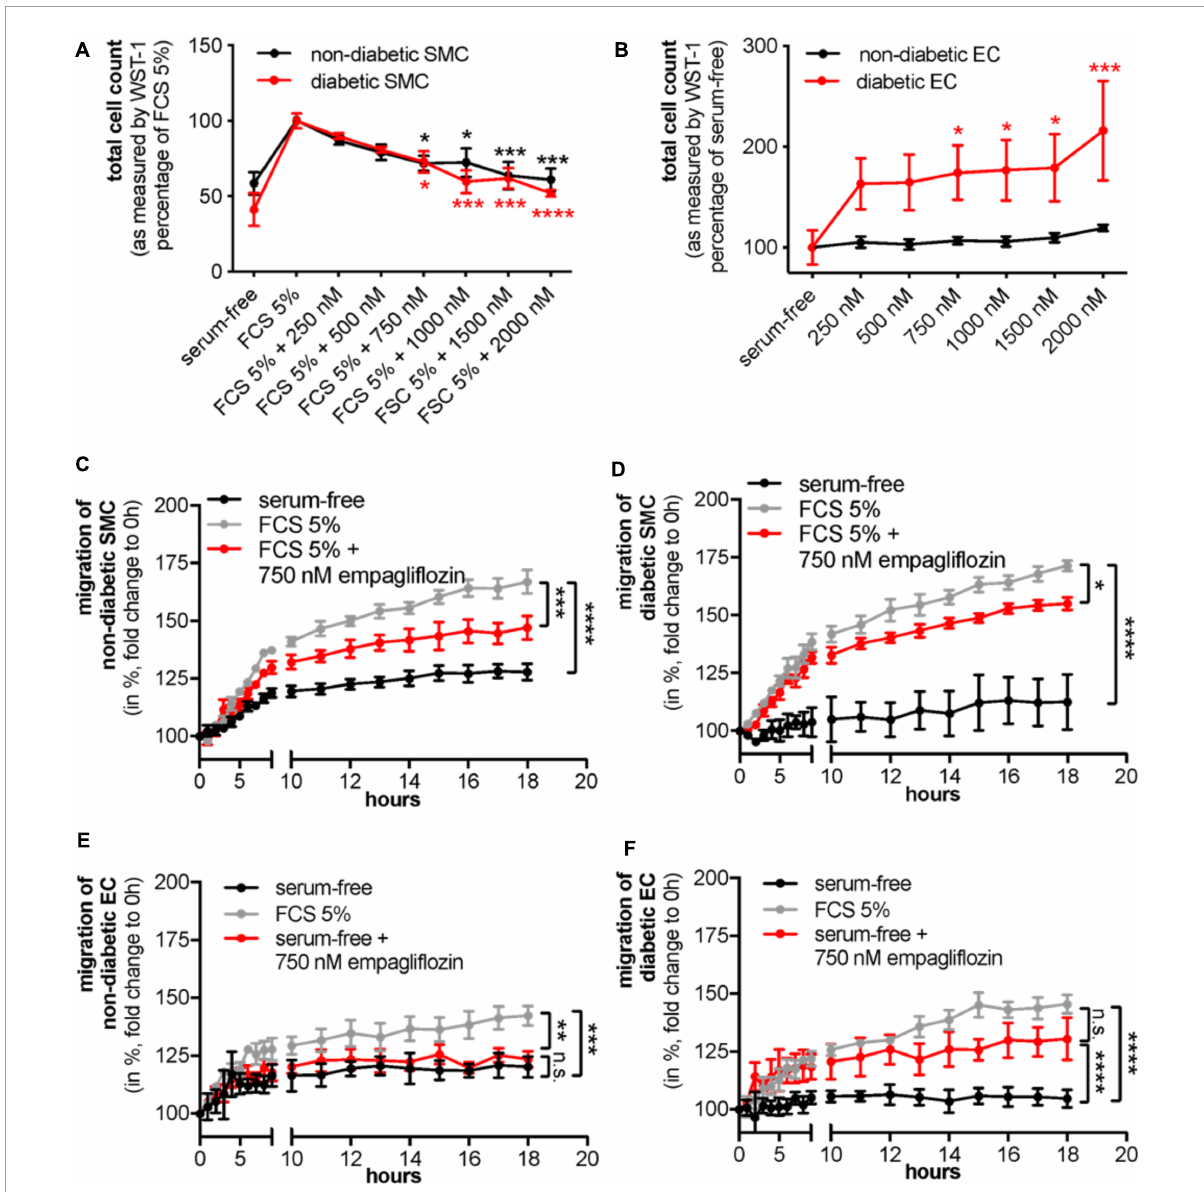
FIGURE2 Empagliflozin improves diabetic endothelial cell (EC) function and prevents diabetic and non-diabetic smooth muscle cell (SMC) proliferation and migration. (A,B) Total cell count assessment of non-diabetic (black) and diabetic (red) SMCs (A) stimulated with 5% fetal calf serum (FCS) and indicated concentrations of empagliflozin and ECs with serum-free medium and indicated concentrations of empagliflozin (B) assessed by WST-1 cleavage to formazan at 24 h. (C–F) Determination of cell migration of non-diabetic (C) and diabetic (D) SMCs in serum free media (black), treated with 5% FCS (gray), and FCS 5% supplemented with 750 nM empagliflozin (red) as well as of non-diabetic (E) and diabetic ECs (F) in serum-free media (black), treated with 5% FCS (gray), and serum-free media supplemented with 750 nM empagliflozin (red) assessed by cell coverage at indicated time points in a scratch-wound assay ( A–F : n = 3, n.s., not significant, * P < 0.05, ** P < 0.01, ***P < 0.001, **** P < 0.0001).